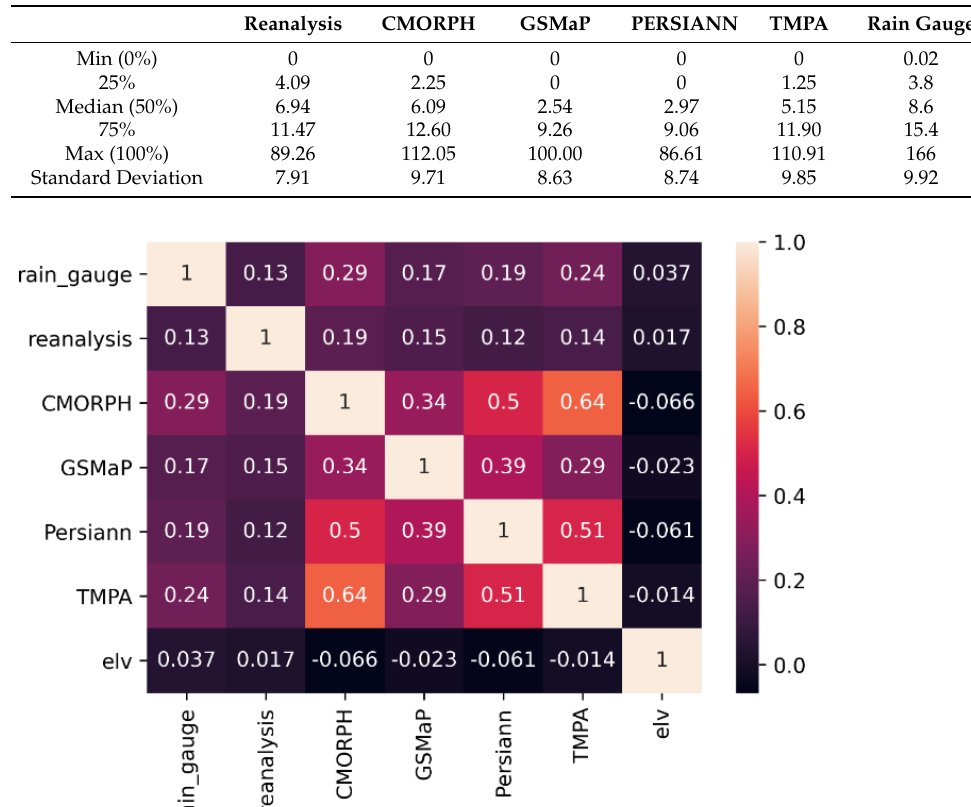
Figure 2. Correlation matrix. A positive/negative (with maximum of +1/ − 1) value indicates a positive/negative relationship (if one value increases, the other increases/decreases) between variables. A value of 0 indicates no relationship.